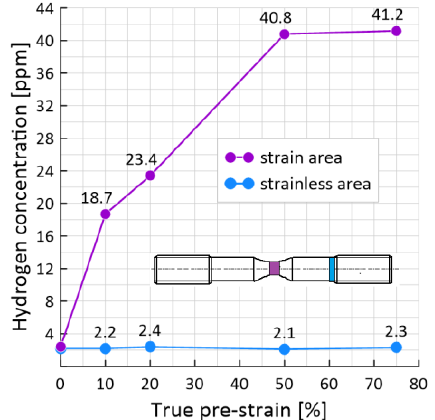
Figure 8. The effect of pre-strain on the hydrogen concentration measured immediately after the experiment in different parts of the sample. experiment in different parts of the